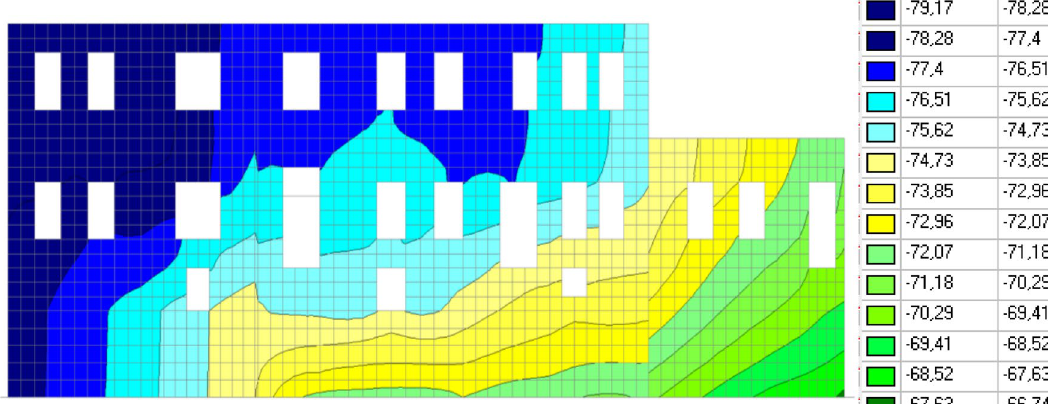
Figure 4. Vertical displacements of the building, mm.